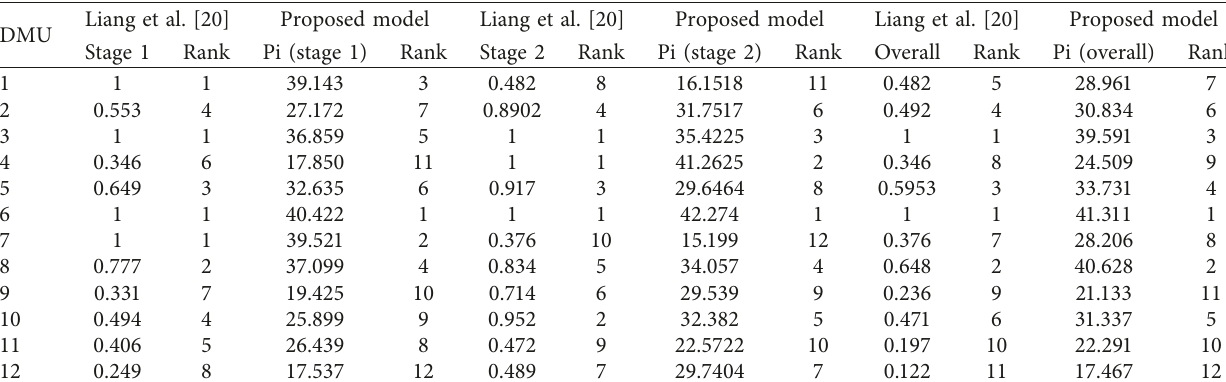
Table 9: Comparison of the ranking of DMUs with the proposed model and Liang et al. [20]